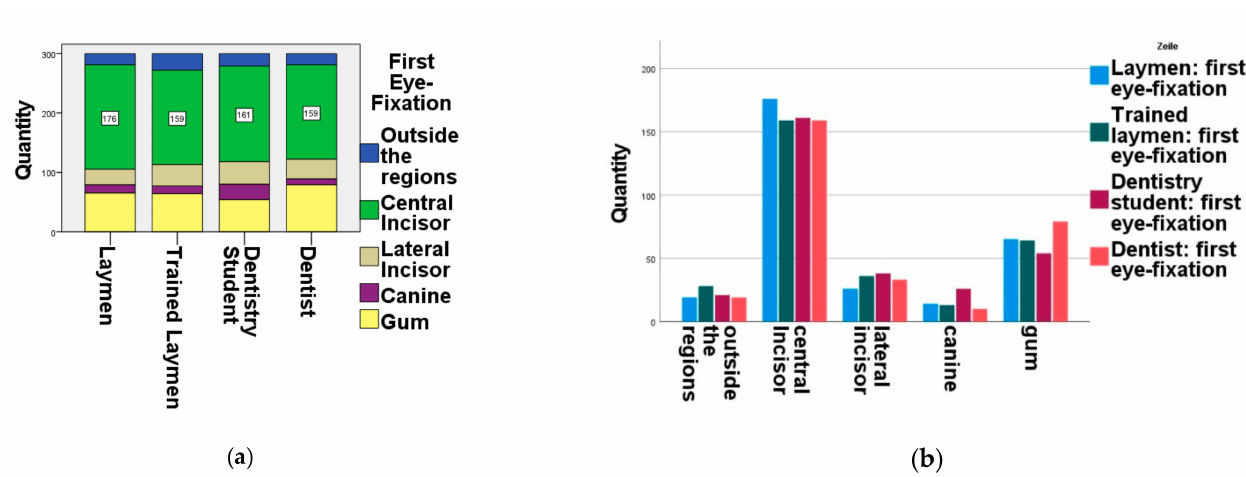
Figure 4. Quantity of first eye fixation illustrated in ( a ) expert level group ( x -axis) and ( b ) first eye-fixation point ( x